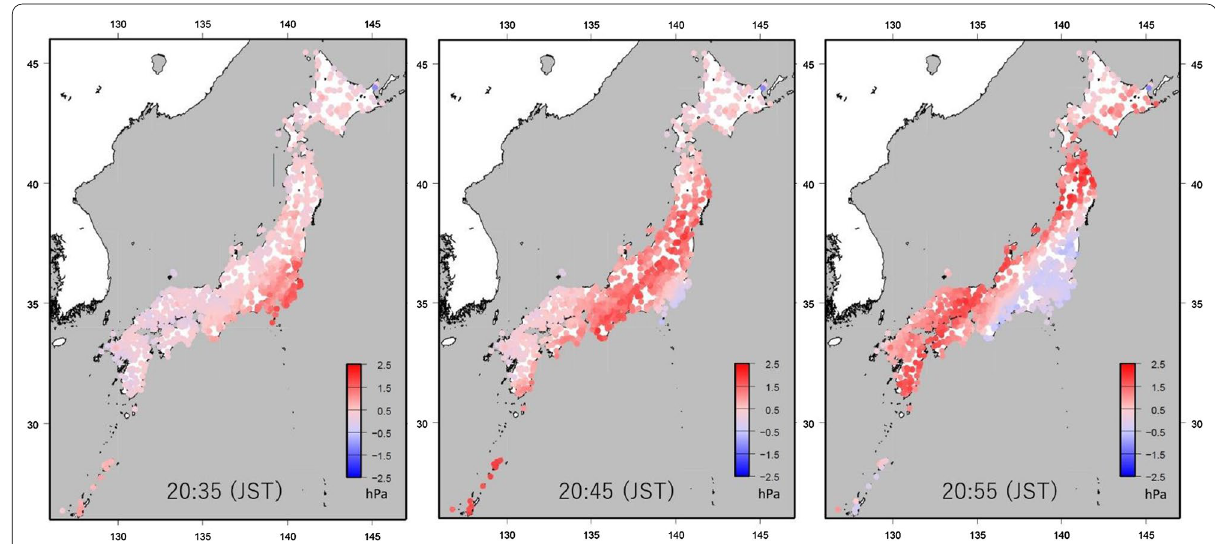
Fig. 2 Three snapshots for the amplitude distribution of pressure changes observed at 1250 stations in Japan (Weathernews Inc., https:// global. weath ernews. com/ news/ 16551/, 2022) at 20:35, 20:45, 20:55 (Japan Standard Time) in 15th of January